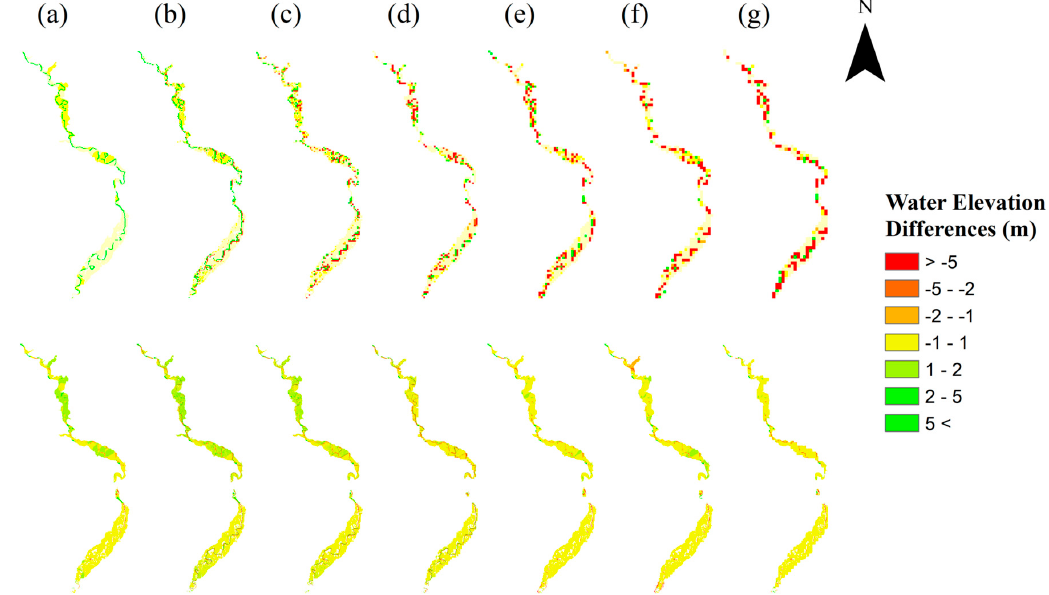
Figure 8. Distribution of simulated surface water elevation differences for coarser resolution models against the reference model using the model resolution ( top ) and the postprocessed 30 m resolution ( bottom ) with: ( a ) 150 m; ( b ) 200 m; ( c ) 300 m; ( d ) 400 m, ( e ) 500 m; ( f ) 600 m; and ( g ) 700 m.